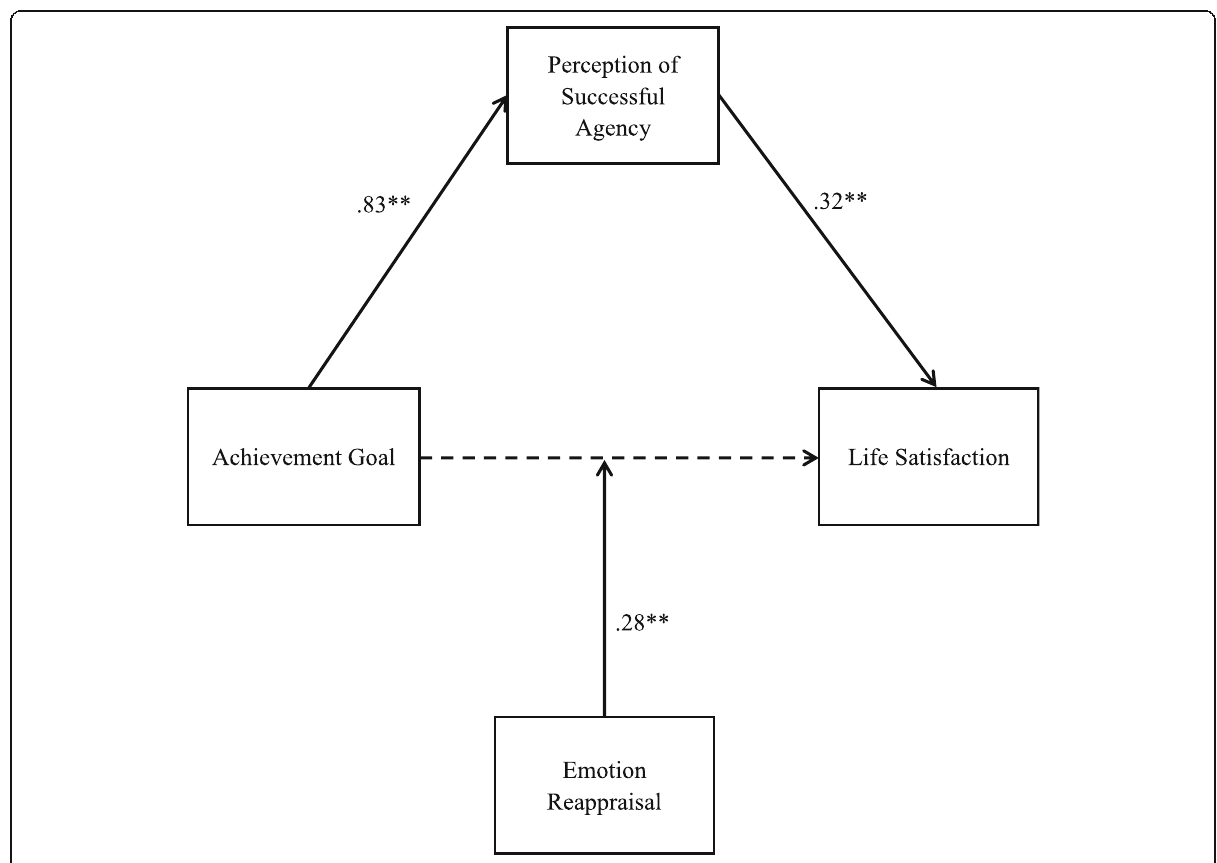
Fig. 2 Conceptual and statistical diagram. Research model with important coefficients. Effect size R 2 = .34, 90% CI [.24,